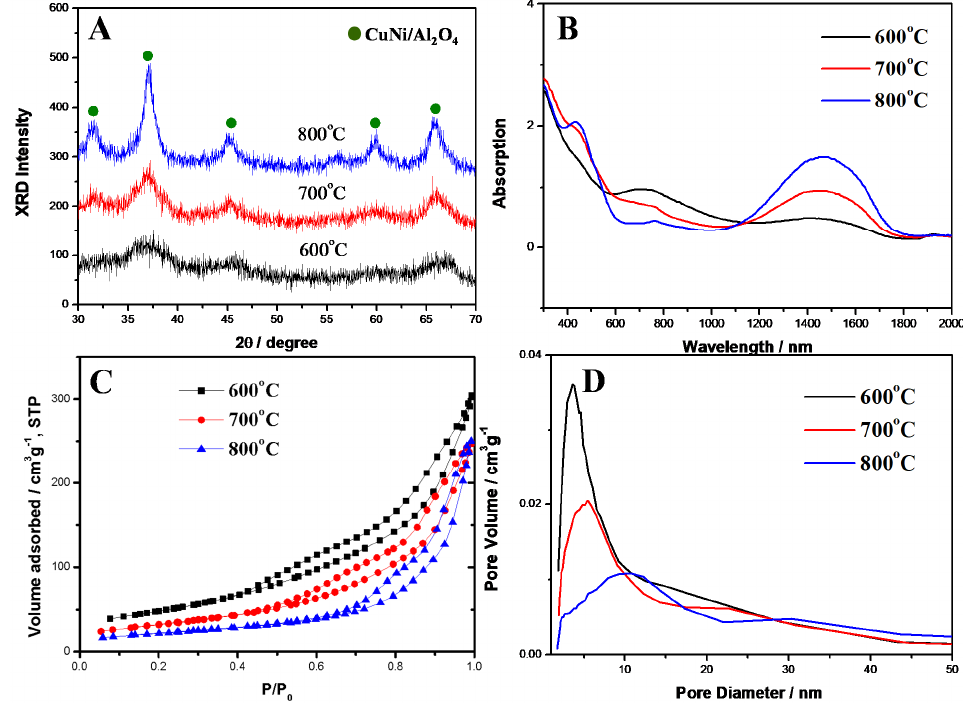
Figure 6. ( A ) XRD patterns, ( B ) DR-UV diagrams, ( C ) nitrogen adsorption and desorption isotherms, and ( D ) BJH pore size plots of the mesoporous Cu-Ni/Al 2 O 4 samples synthesized at different calcination temperatures.